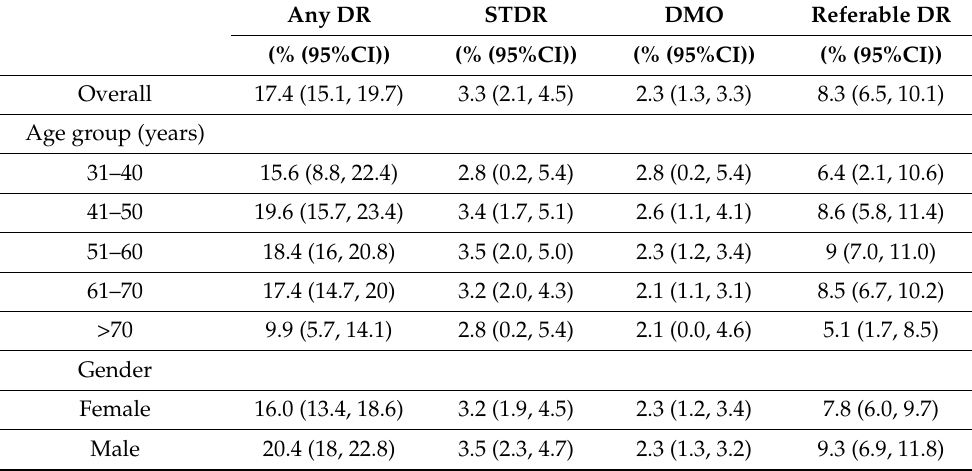
Table 3. Age- and gender-standardised prevalence of DR ( N = 4527).